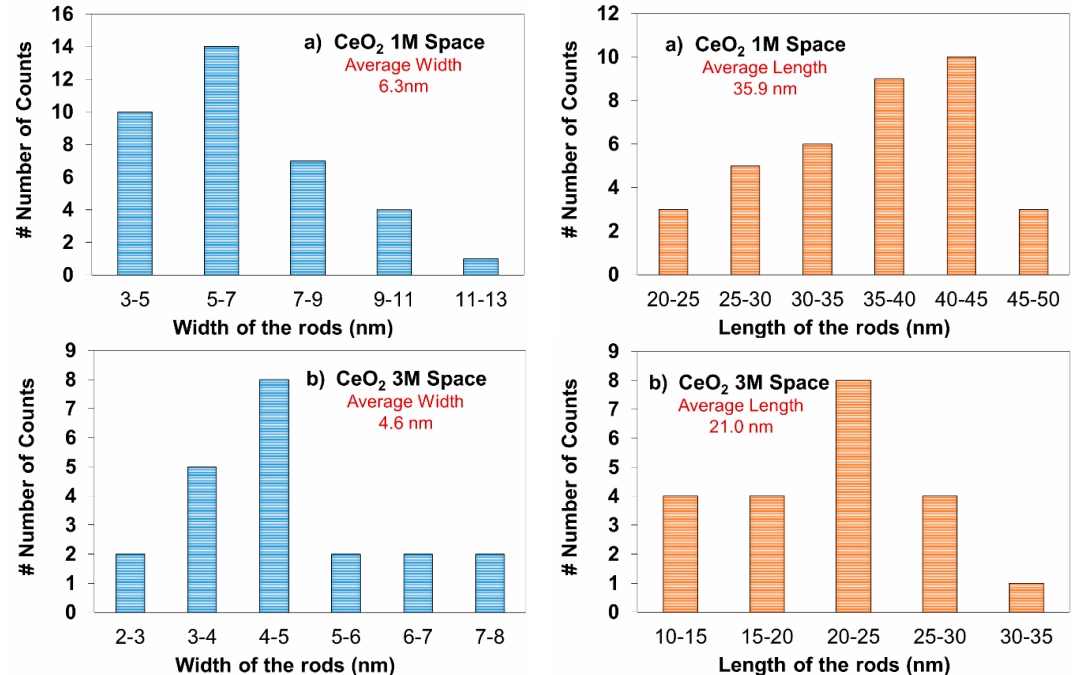
Figure 5. Width and length distribution histogram of Space CeO 2 sample: ( a ) 1 M; ( b ) 3